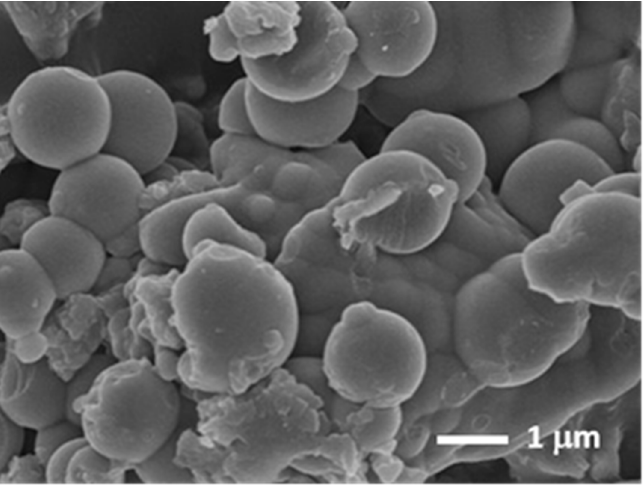
Figure 3. SEM image of ZnGA-Al-1 showing thick layers of AlCl 3 on the ZnGA.